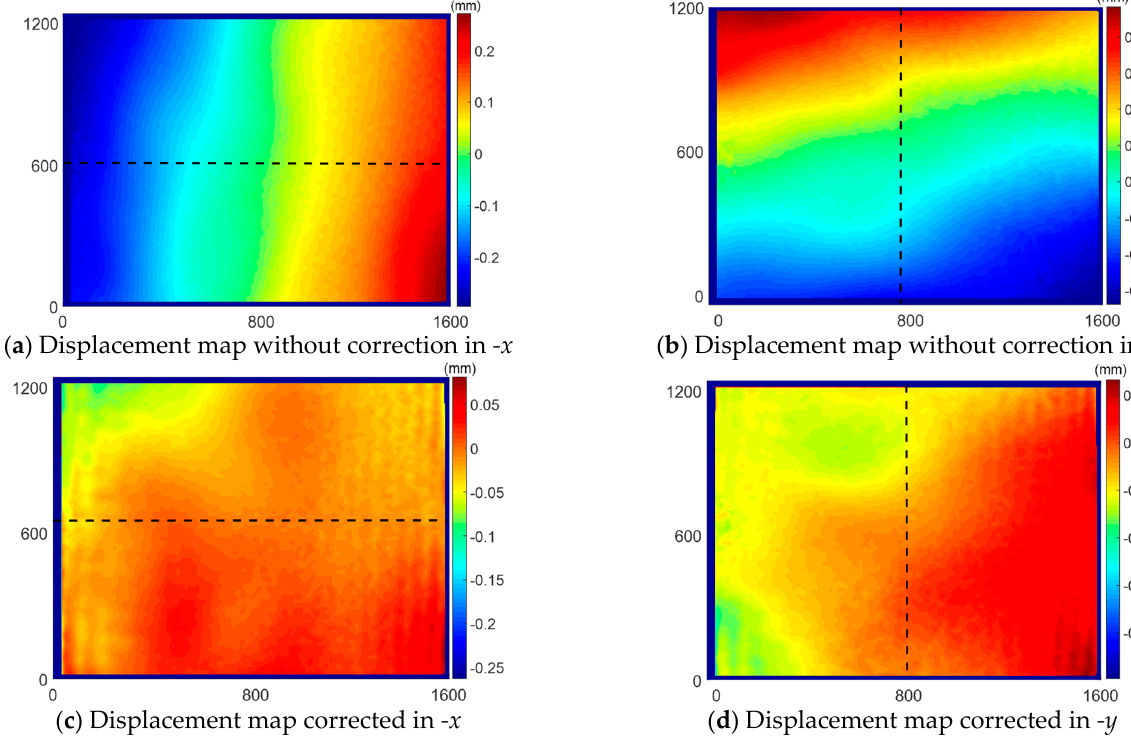
Figure 4. Displacement maps in-plane without correction ( a , b ) and corrected ( c , d ).